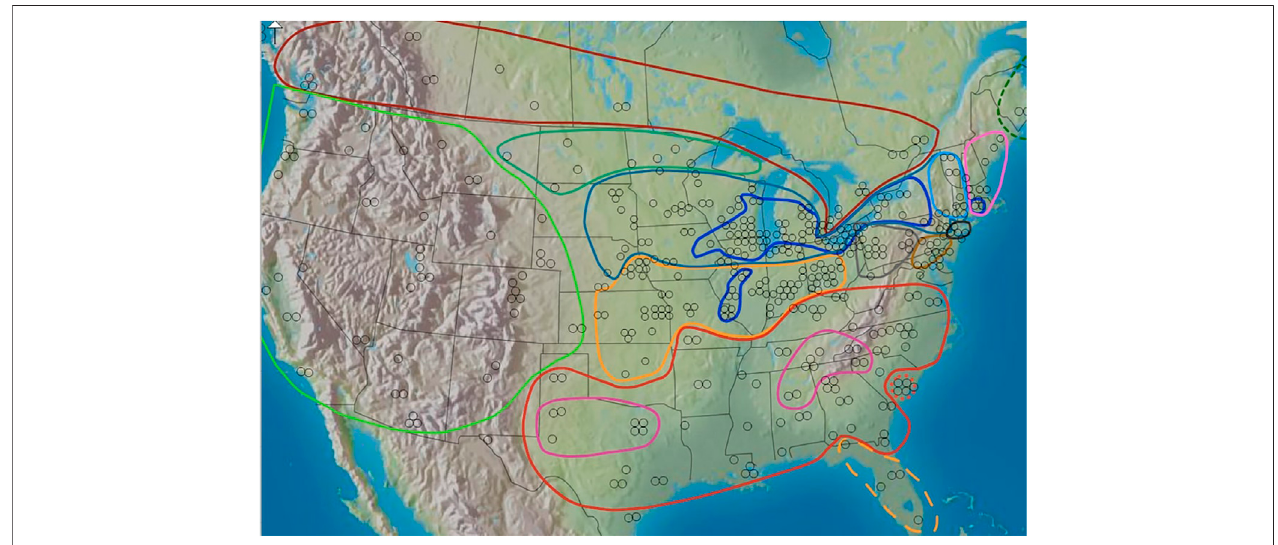
FIGURE 2 | North American dialect regions as outlined in the ANAE. Dark blue (cid:1) Inland North. Red (cid:1) South. Map to be reprinted from Labov et al. (2006).